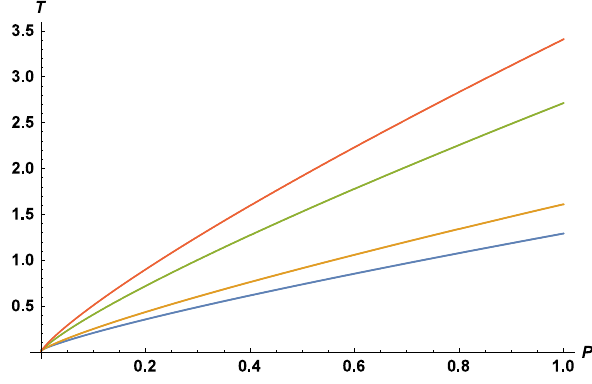
Fig. 1 Inversion curves of Kerr–AdS black hole in T – P plane. From bottom to top,the curves correspond to J = 1 , 2 , 10 , 20